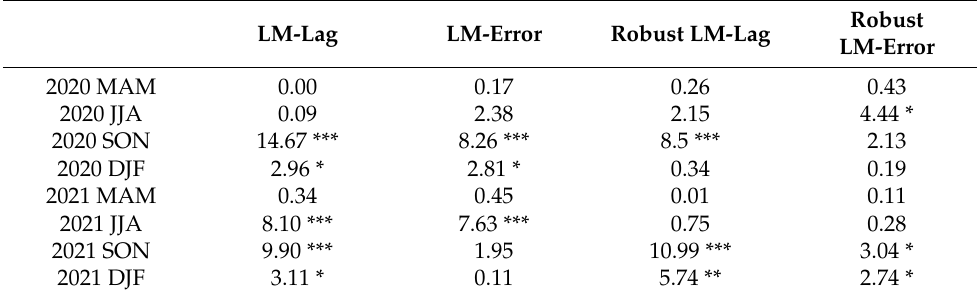
Table A3. LM-lag, LM-error, Robust LM-lag, and Robust LM-error tests for the OLS residuals